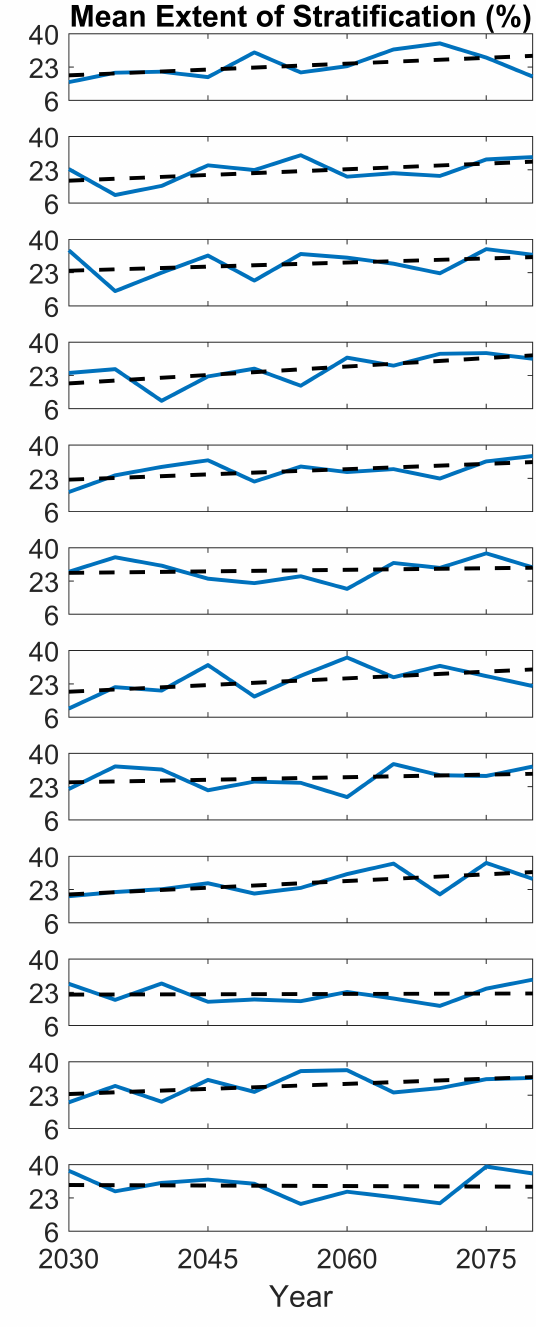
Figure 9. Compiled results from the twelve UKCP18 modelled scenarios used across the range of years, including the number of days of stratification ( left column) and the mean surface area, as a percentage of the reservoir, that was stratified ( right